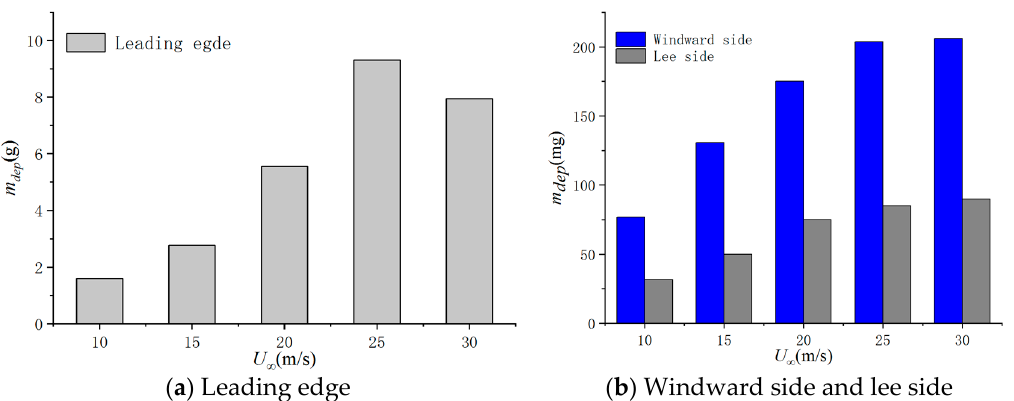
Figure 11. Deposition mass with different mainstream velocities.